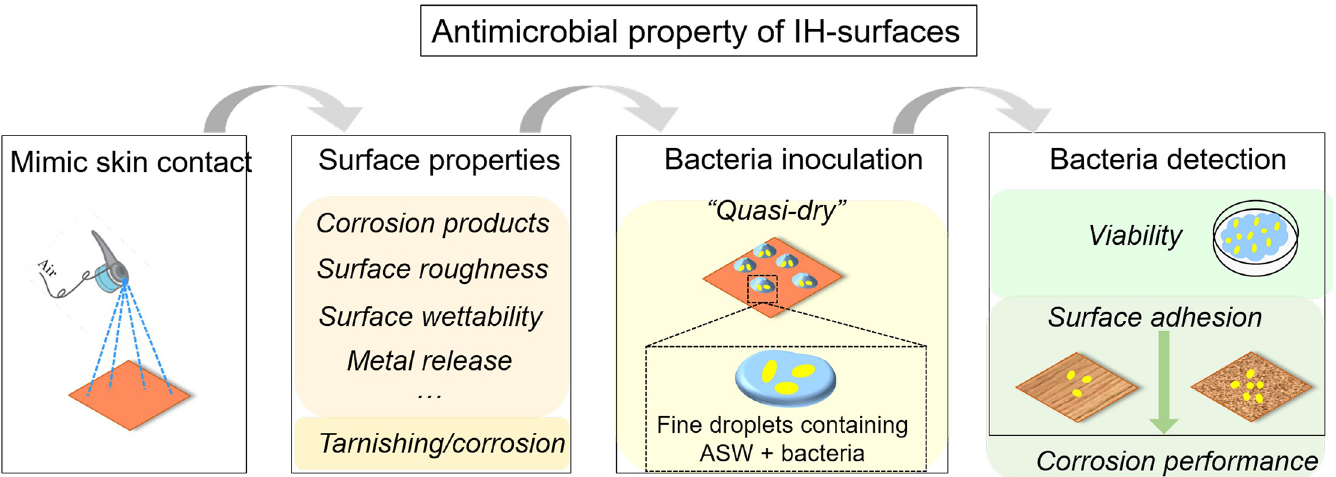
Fig 13. Schematic illustration of the test methodology and investigated properties to assess the surface characteristics and antimicrobial properties of high-touch surfaces. Cu metal was used as benchmark material in this study.